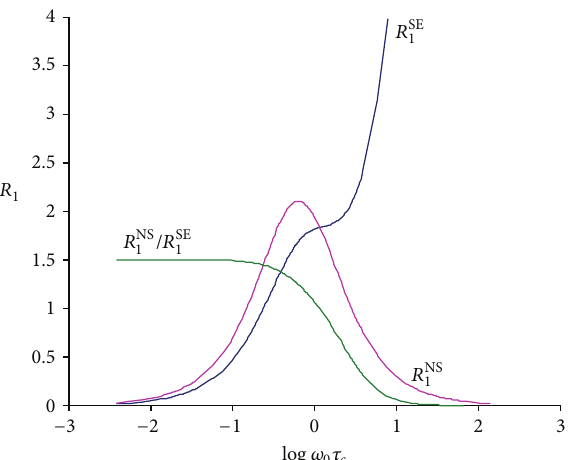
Figure 1: Dependence of selective and nonselective spin-lattice relaxation rates of the motion parameter 𝜔 0 𝜏 𝑐 .